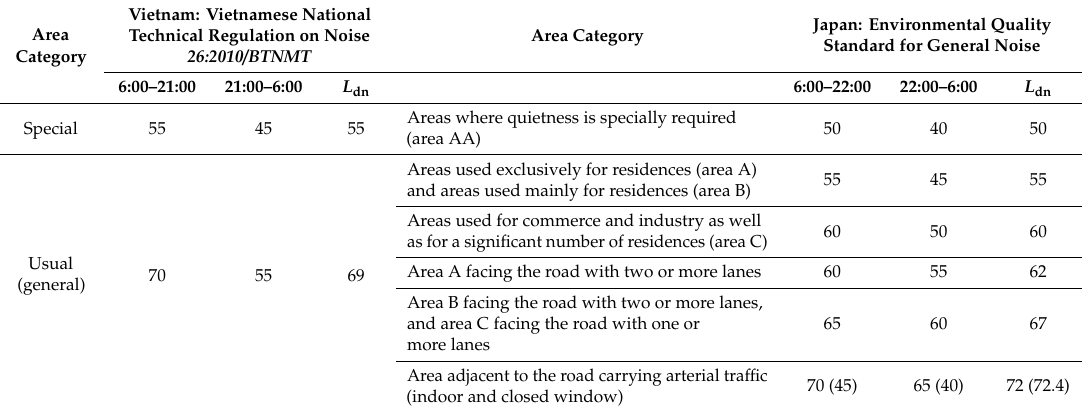
Table 3. Comparison of noise limits for general environmental noise between Vietnam and Japan